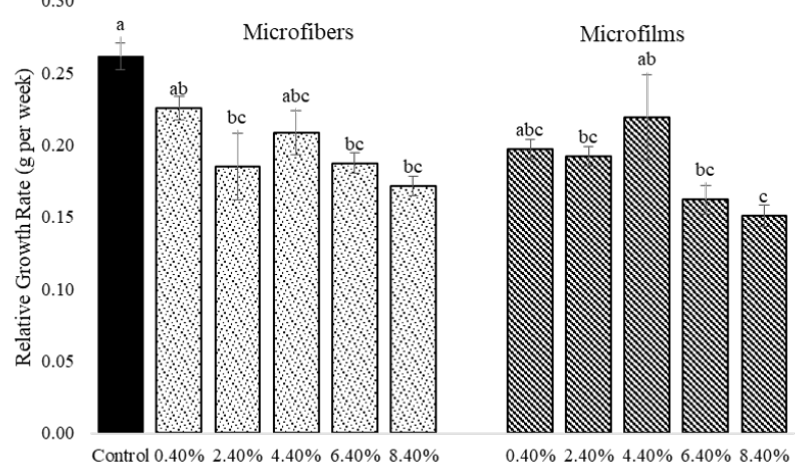
Figure 2: Relative Growth Rate (dry weight in g per week) of tomato seedlings grown in different concentrations of microfibers and microfilms (0.0, 0.4, 2.4, 4.4, 6.4, and 8.4% w/w). Different letters indicate significant differences between means. Two-way ANOVA: MP type F = 1.46; p = 0.232; MP concentrations, F = 13.74, p ≤ 0.000). Error bars indicate the standard error of the mean value (SEM).